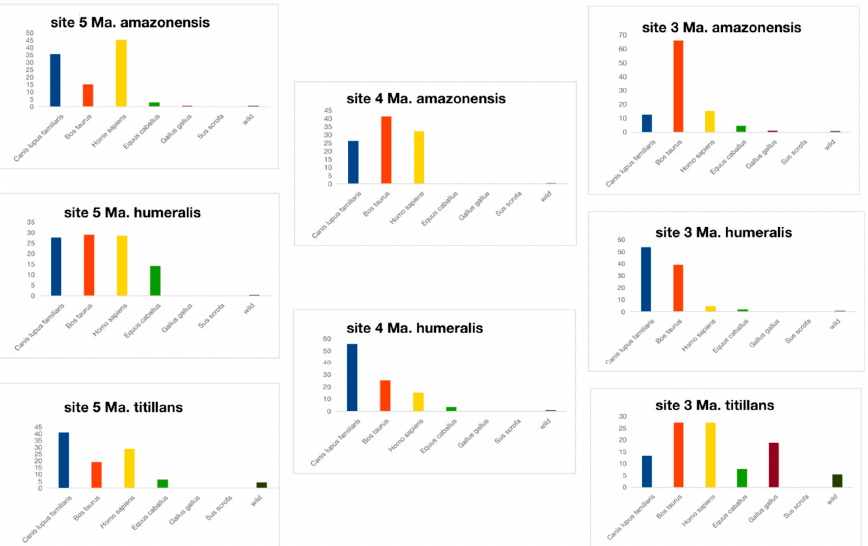
Figure 5. Bar charts representing the proportion of ingested blood from different hosts for each Mansonia species sampled in sites 3, 4, and 5. Only the species that were found statistically significant for the comparisons within each locality are represented in the figure (according to Table 2).